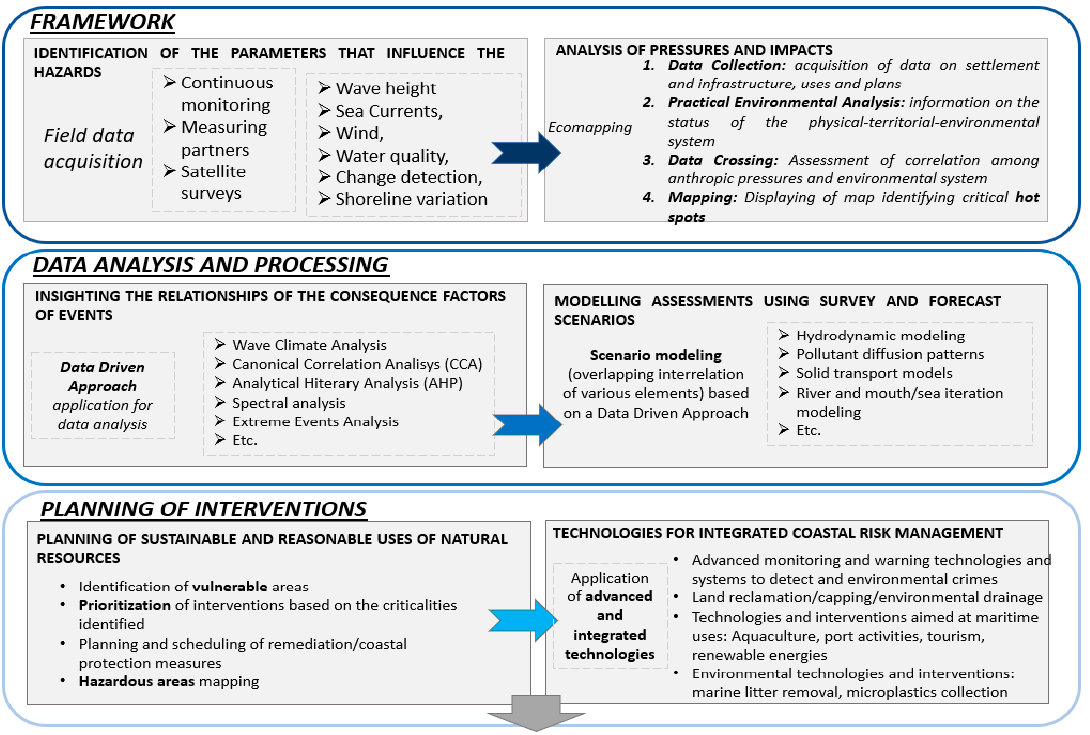
Figure 1. Main analysis phases to support the risks management strategy.